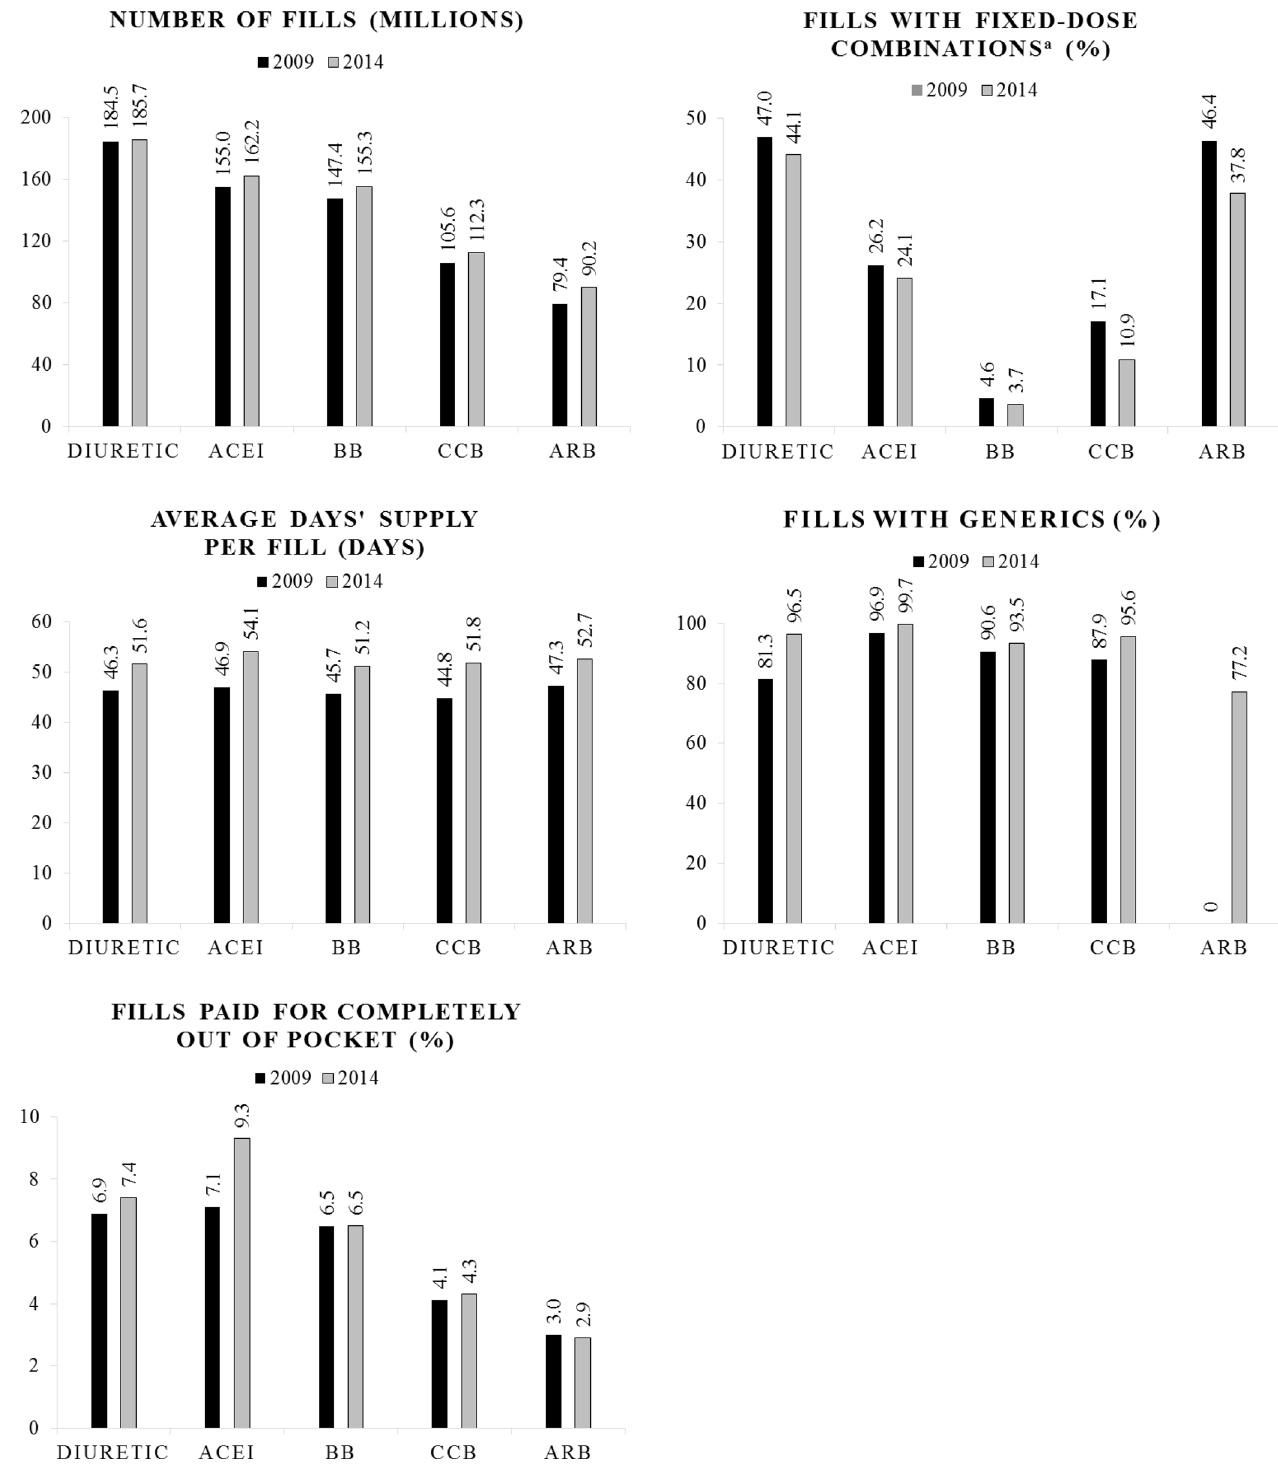
Fig 1. Prescription-related Factors that Promote Adherence to Blood Pressure-lowering Medications by Class, 2009 and 2014. ACEI indicates angiotensin converting enzyme inhibitor; BB, beta blocker; BP, blood pressure; CCB, calcium channel blocker; and, ARB, angiotensin II receptor blocker. a Fixed-dose combinations contain more than one active BP-lowering medication ingredient per pill. Source: IMS Health National Prescription Audit, 2009 – 2014.